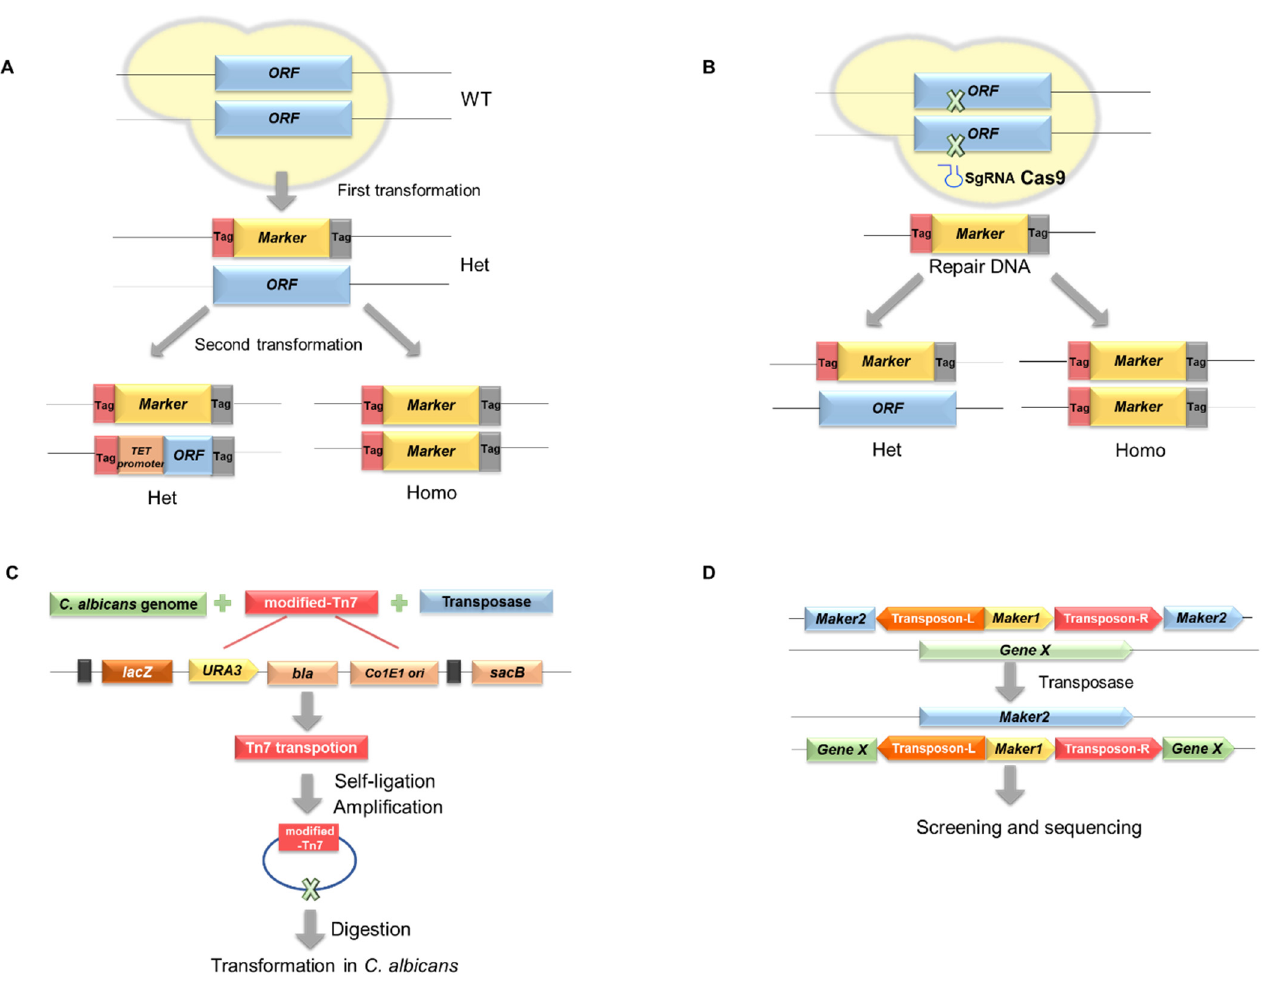
Figure 1. Methods used to construct the mutant library in C. albicans. ( A , B ) Schematic description of mutant library construction based on homologous recombination. ( A ) Traditional methods of homologous recombination used in gene deletion and conditional gene expression. ( B ) Schematic description of CRISPR/Cas9 technology. The commonly used markers include neutral auxotrophic markers ( URA3 , HIS1 , ARG4 , and LEU2 ) or drug-resistant marker ( SAT1 ). Specific DNA barcodes are usually designed in the upstream and downstream of the markers, which could be used to distinguish each mutant by high-throughput sequencing. ( C ) Schematic description of modified-transposon mutagenesis [19]. C. albicans genomic DNA fragments digested with restriction enzyme were mixed with the Tn7 transposase and plasmid containing a modified Tn7 transposon. After the transposition, the modified Tn7 transposon inserted genomic DNA was ligated, and then transformed to E. coli . The plasmids were amplified and digested with restriction enzyme. Then the linear DNA fragments were transformed to C. albicans strain, which could integrate into the C. albicans genome by homologous recombination. The insertion mutants were collected and used as a heterozygous mutant library. ( D ) Transposition-mediated insertion mutant library construction in haploid C. albicans . Insertion of a transposon into marker2 results in mutation and loss of resistance. The transposition was initiated by the conditional expressed transposase. The transposed strains recovered the integrity of marker2, which could be used to screen positive clones. Het, heterozygous; Homo, homozygous.